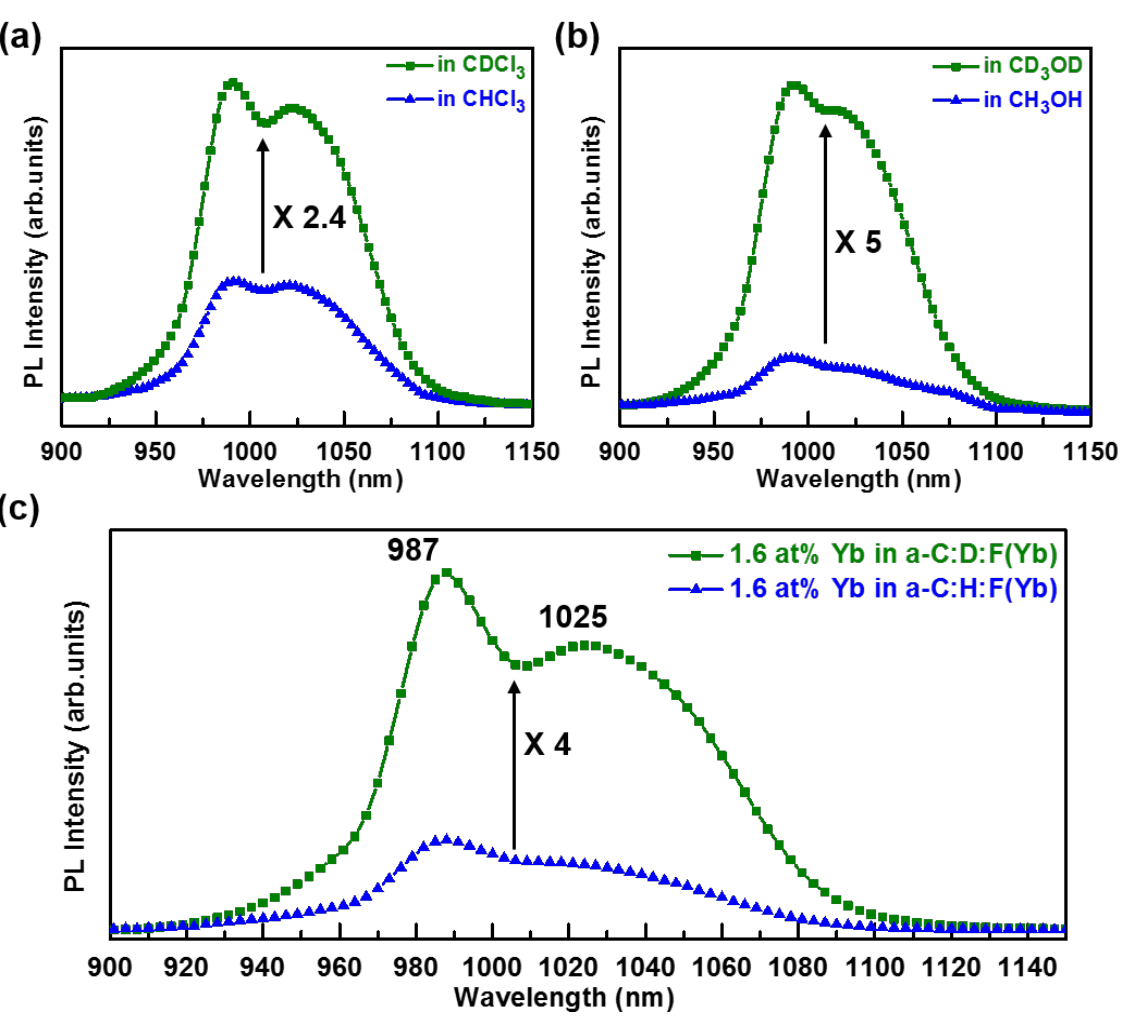
Figure 1. Comparison of the Photoluminescence (PL) intensity of Yb(fod) dissolved in ( a ) chloroform (CHCl ) and chloroform-d (CDCl 3 and methanol-d (CD OD); ( c ) Comparison of the PL intensity of a-C:D:F(Yb: 1.6 at % ) 4 3 and a-C:H:F(Yb: 1.6 at %) films prepared using RF power of 60 W, precursor gas flow rate of 20 sccm, deposition pressure of 60 mTorr, substrate temperature of 90 °C, and Yb(fod) powder evaporation temperature of 110